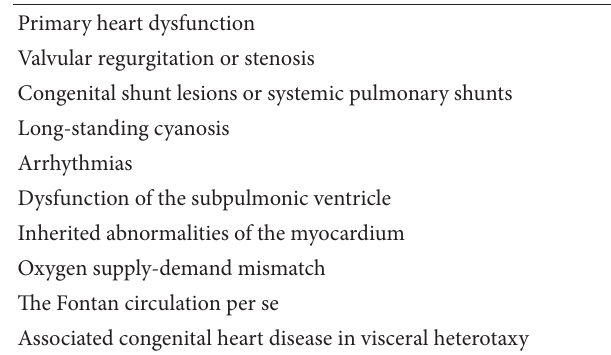
Table 2: Etiology of heart failure in congenital heart